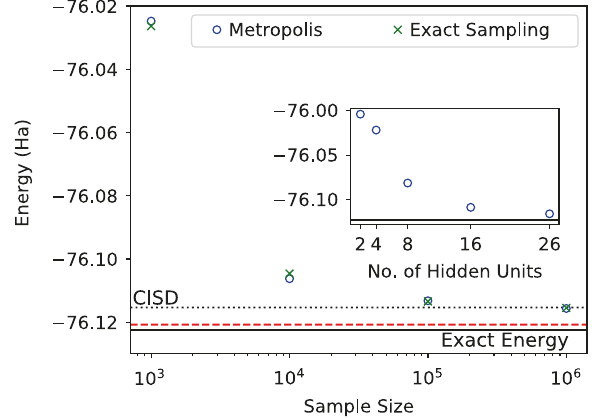
Fig. 4 Sampling size dependence of the converged energies. Converged energy of H 2 O in the 6-31g basis (26 spin-orbitals) as the number of samples used for each VMC iteration is varied. The converged energy for the samples obtained using the Metropolis algorithm (blue circles) matches that obtained using exact sampling (green crosses), beating the accuracy of CISD and approaching chemical accuracy (red line) for the largest sample size. In the inset, we also show the variational energy as the number of hidden units is increased from 2 to